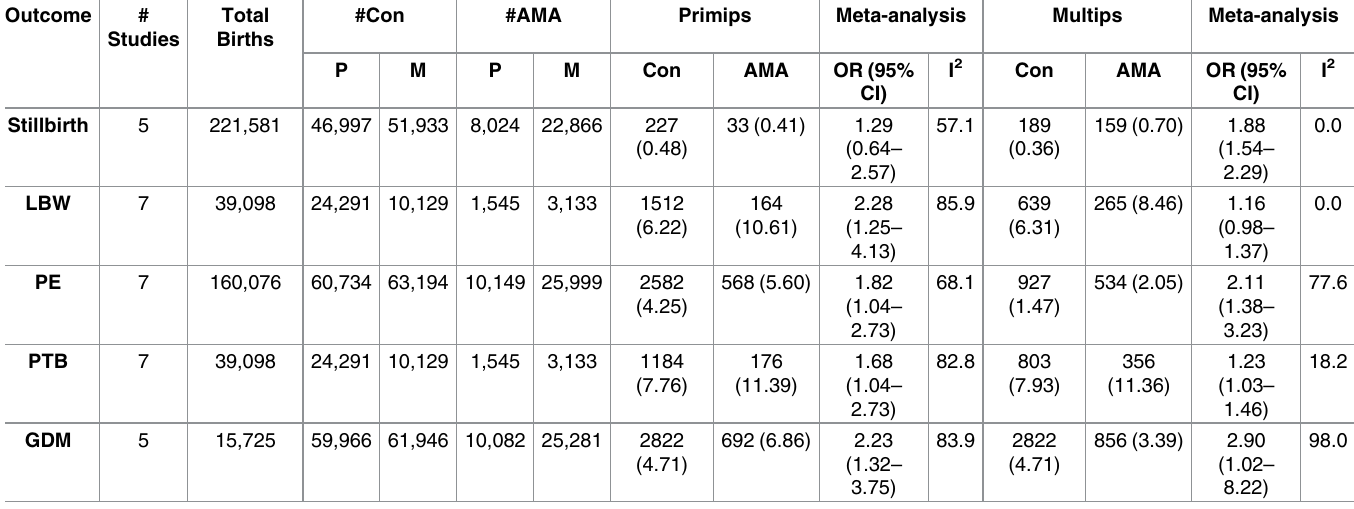
Table 2. Meta-analysis of parity effects on primary and secondary